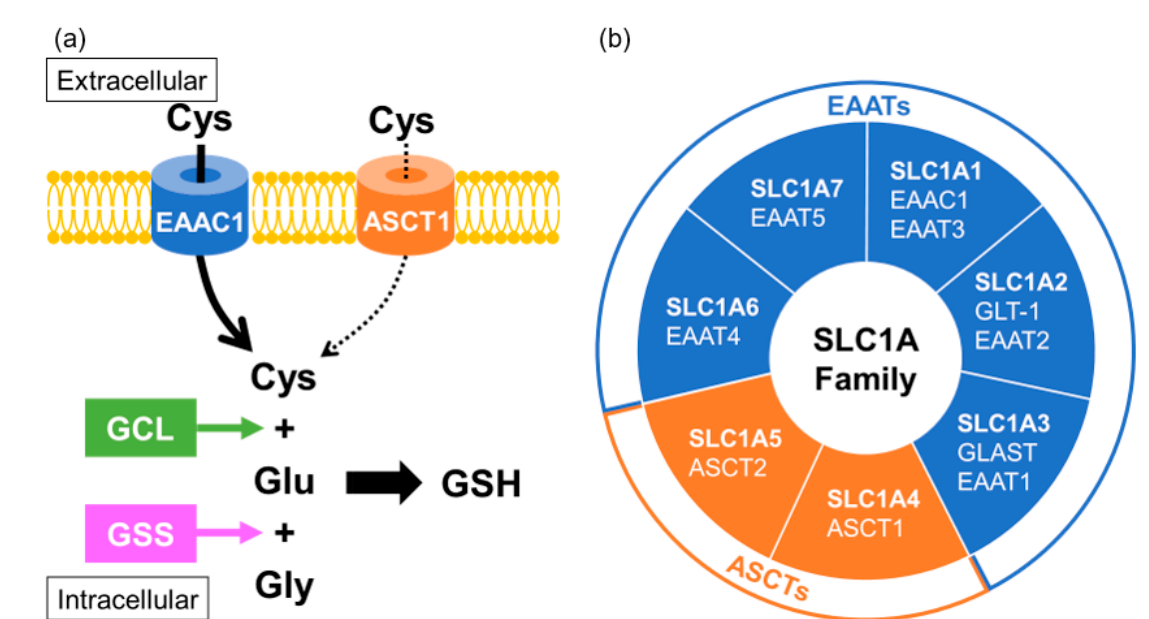
Figure 3. Biosynthesis of intracellular glutathione in neurons, microglia and oligodendrocytes. ( a ) Glutathione (GSH) is comprised of three amino acids: cysteine (Cys), glutamate (Glu) and glycine (Gly), of which Cys is rate-limiting, with its uptake mainly mediated by EAAC1. ASCT1 also contributes to Cys uptake, but its ability might be more limited. Transported Cys is conjugated with Glu catalyzed by glutamate-cysteine ligase (GCL) and then couples with Gly to form GSH. ( b ) EAAC1 and ASCT1 are members of the SLC1A family, comprised of excitatory amino acid transporter (EAAT) and neutral amino acid transporter (ASCT) subtypes.